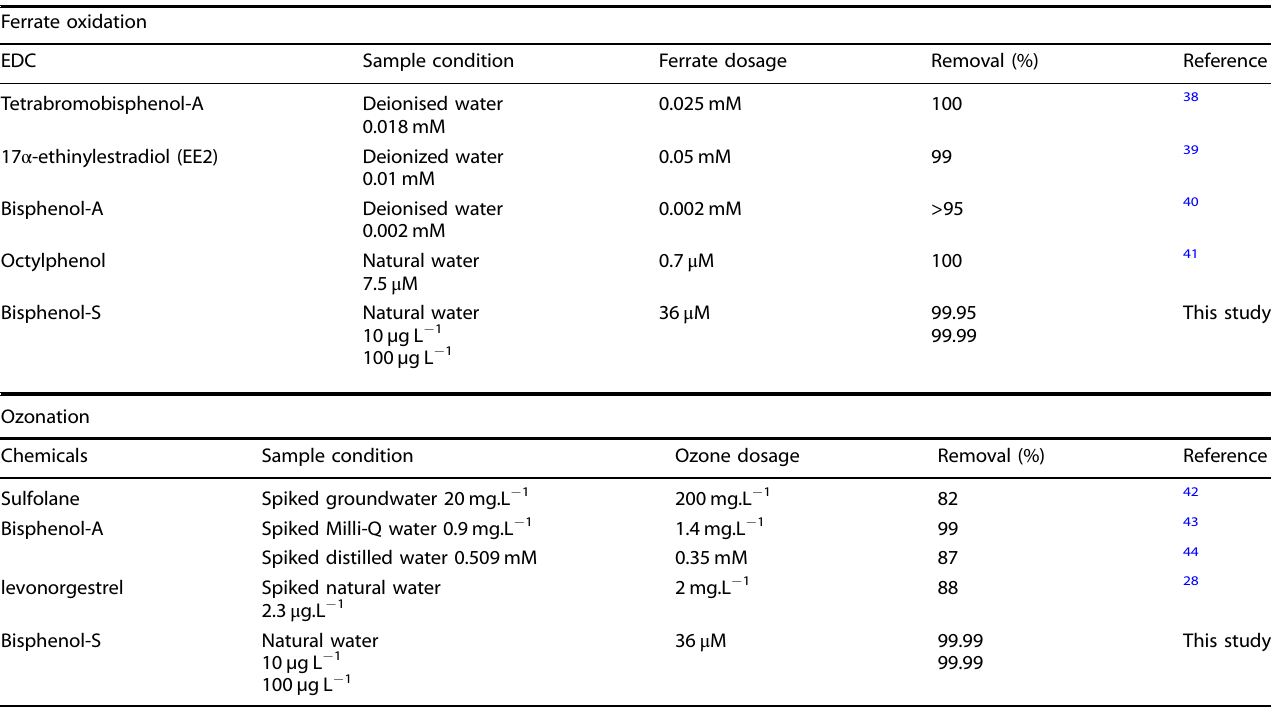
Table 2. Comparative reduction of EDCs with ferrate oxidation and ozonation. Ferrate